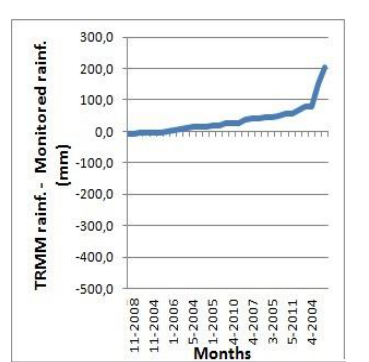
Figure 13. Monthly overestimation